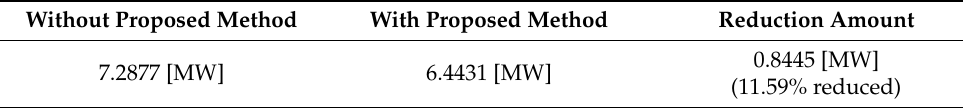
Figure 12. Histogram of the maximum load reduction in 11000 DLs. Table 4. The maximum load as an average in 11,000